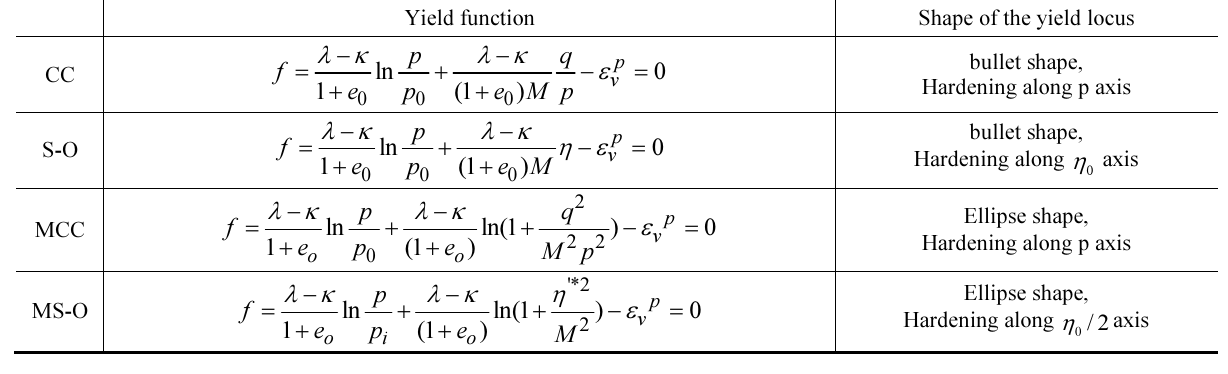
steps. Field displacement measurement was performed during the excavation process. Six points of slope are selected to carry out the comparison of measured and calculated displacements. The node numbers of these six points in finite element mesh (which are 172, 176, 197, 216, 254 and 255) and according measurement location